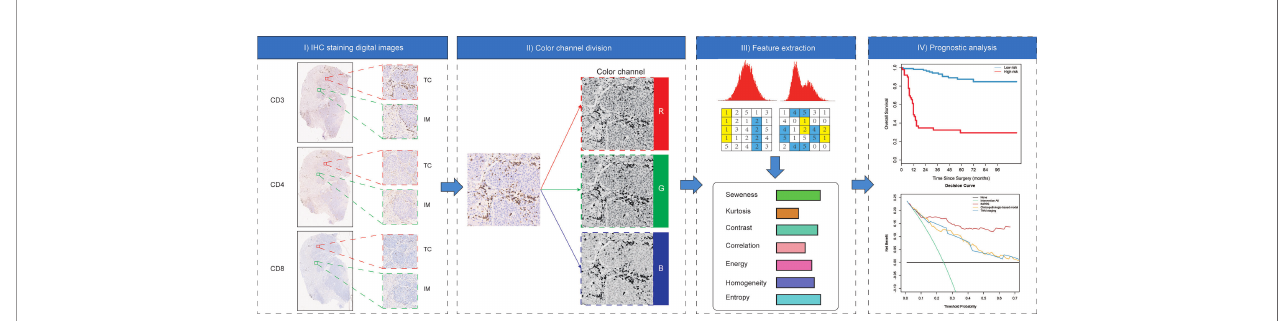
FIGURE 2 | The work fl ow for the immunohistochemistry (IHC)-immune feature extraction.